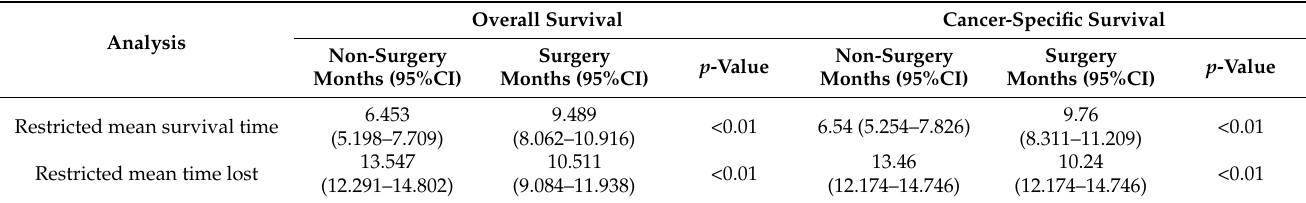
Table 3. Cox regression analysis of overall survival.